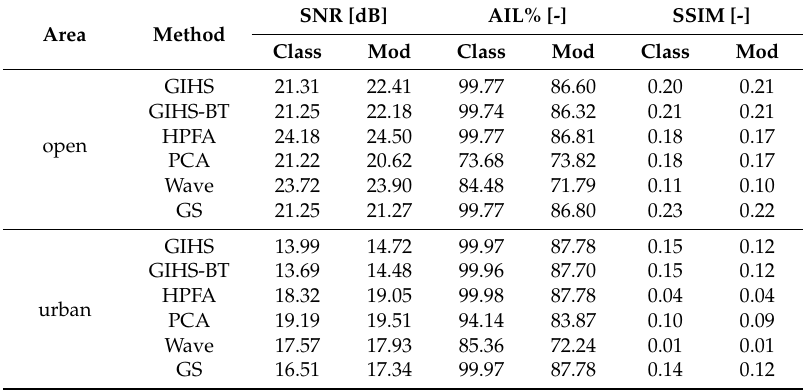
Table 3. Quality assessment indices for the fusion of Landsat 5 TM and WorldView-2 imagery data using the classical (class) and modified (mod)